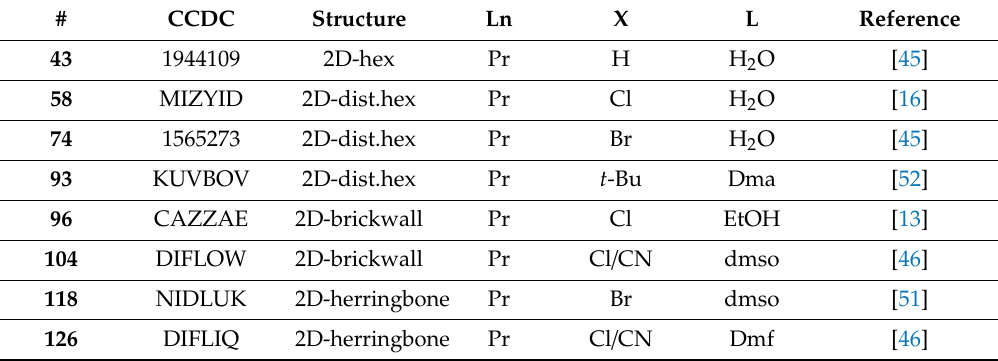
Table 16. Structurally characterized Pr(III) compounds with anilato ligands.